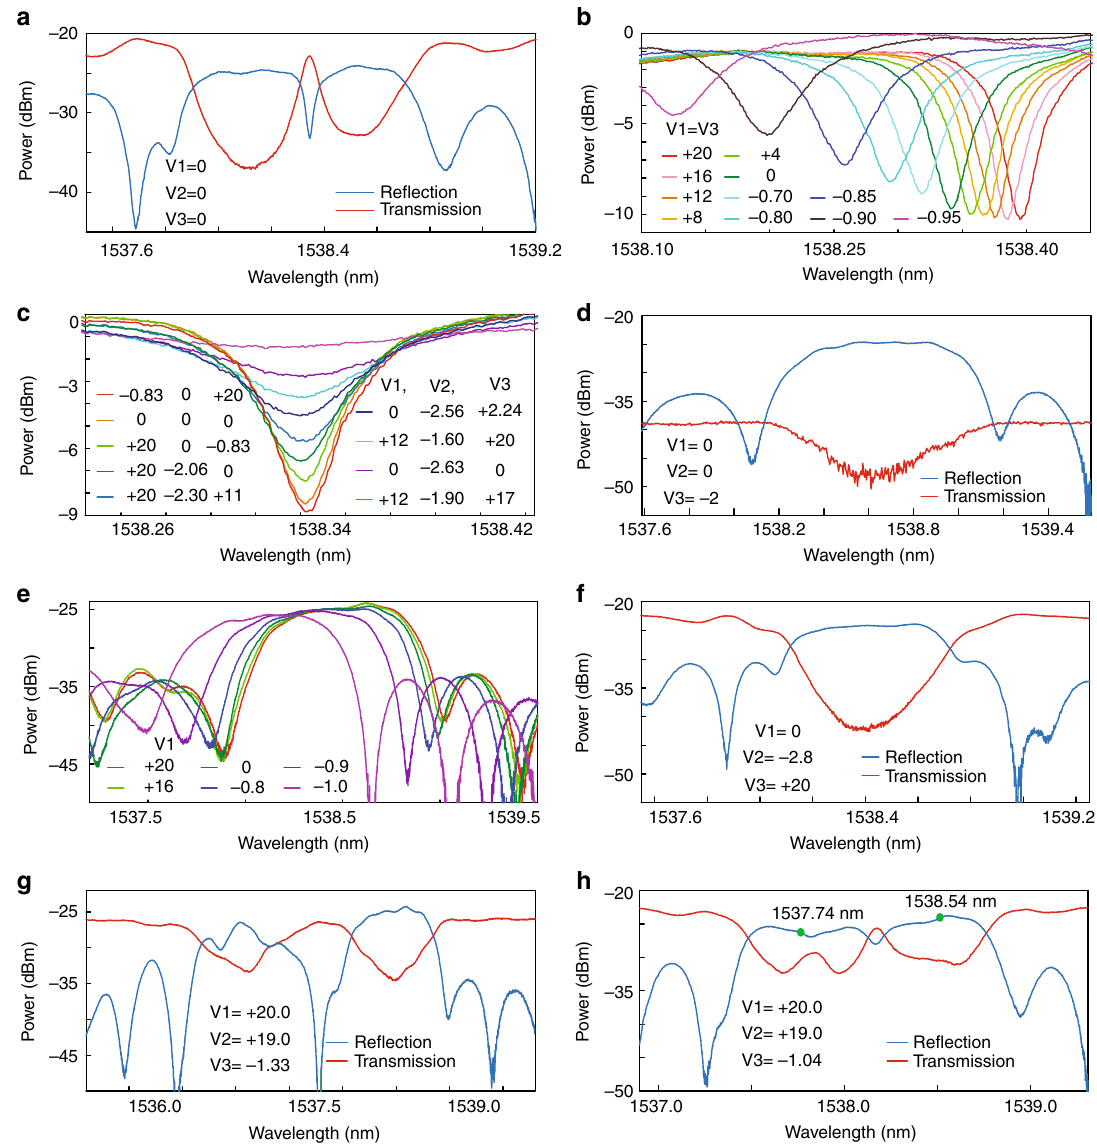
Fig. 3 Measured re fl ection and transmission spectra. a Re fl ection and transmission spectra of the fabricated grating in the static state. b Notch wavelength shift when the bias voltages applied to the left and right sub-gratings vary synchronously. c Extinction ratio tuning while the notch wavelength is kept unchanged. d Re fl ection and transmission spectra when the grating is recon fi gured to be a uniform grating. e Wavelength tuning of the uniform grating. f Re fl ection and transmission spectra when the device is recon fi gured to be a uniform grating by increasing the cavity loss. g Re fl ection and transmission spectra when the device is recon fi gured to be two independent uniform sub-gratings. h Re fl ection and transmission spectra when the device is recon fi gured to be a chirped grating (The bias voltages and the power consumptions for different grating operation regimes are summarized in Supplementary Note (maximum value) when the bias voltage combination is “ − 0.825, failing the optical con fi nement capability of the FP cavity, by applying a large forward bias voltage to the right PN junction. extinction ratio is 0.8 dB (minimum value) when the bias voltage Figure 3d gives the measured re fl ection and transmission spectra of the grating when a large forward bias voltage of − 2 V is applied to the right PN junction. The large forward bias voltage enables the injection of massive free-carriers into the waveguide, which would cause a heavy optical absorption loss and thus disable the re fl ection capability of the right sub-grating. As can be seen, there is one main peak in the re fl ection or a notch in the transmission spectra, which is a distinct feature of a uniform grating. Moreover, the insertion loss at the transmission port is much larger than the one at the re fl ection port, which is caused by the heavy optical absorption loss in the right sub-grating wave- guide. In the re fl ection spectra, the re fl ection peak has a